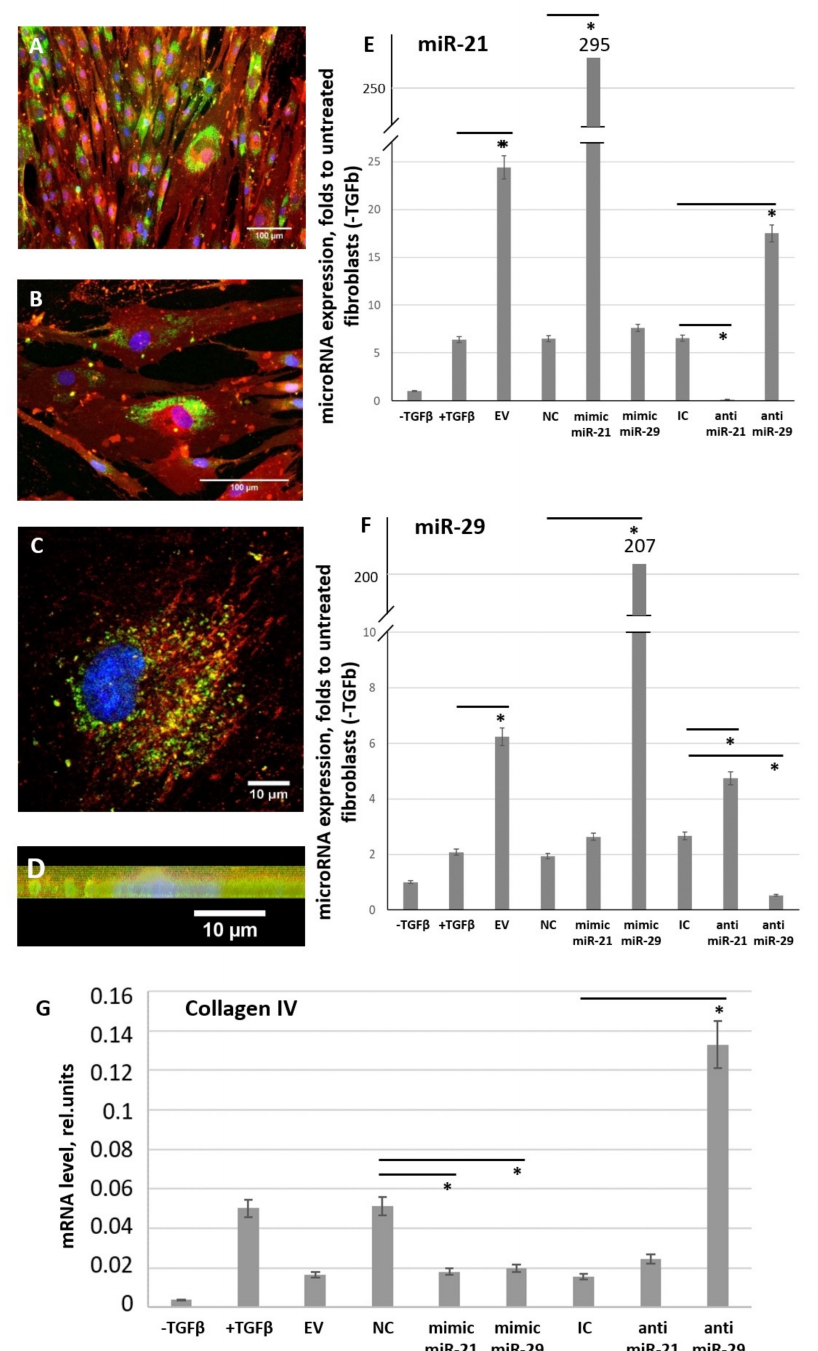
Figure 10. MSC-EV transfer microRNAs from MSC to fibroblasts within MSC-EV. ( A – D ) Uptake of MSC-EVtransfectedwithFAM-labeled(green)oligosbyfibroblastsafter48hofincubation. ( A , B )wide-field microscopy, ( C )confocalmicroscopy, ( D )confocalmicroscopy, sagittalsection. Immunofluorescentanalysis (FAM (green), PKH26 (red), DAPI (blue)). ( E , F ) Expression of miR-21 ( E ) and miR-29c ( F ) in cultured control fibroblasts ( − TGFbeta) and in fibroblast after exposure to TGFbeta ( + TGFbeta) incubated for 96 h in the presence of MSC-EV transfected with specific microRNA mimics or antagomirs. Real-time PCR was used for the analysis. The results were normalized to the untreated control fibroblasts ( −